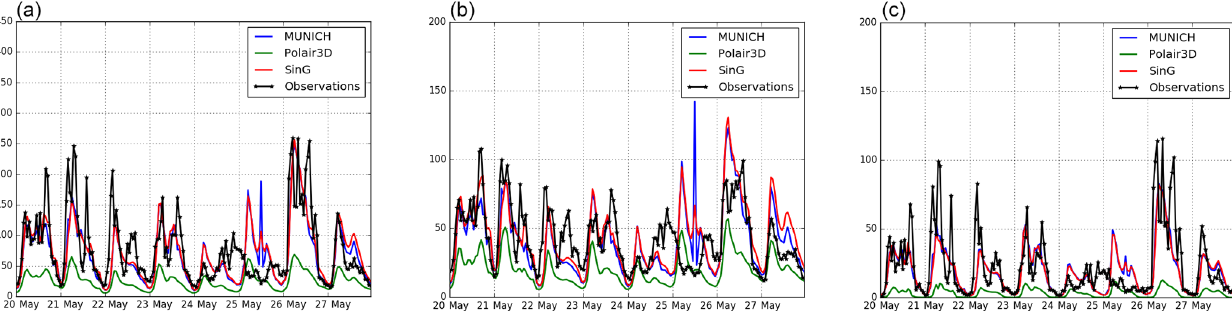
Figure 11. Hourly average NO x (a) , NO 2 (b) and NO (c) concentrations (µgm − 3 ) observed and simulated at SOULT station with MUNICH, SinG and Polair3D. Table 6. Average concentrations measured and simulated with SinG of NO x , NO 2 , NO and NO 2 / NO ratios at traffic stations ( o and s represent the observed and simulated average, respectively; µgm − 3 ).